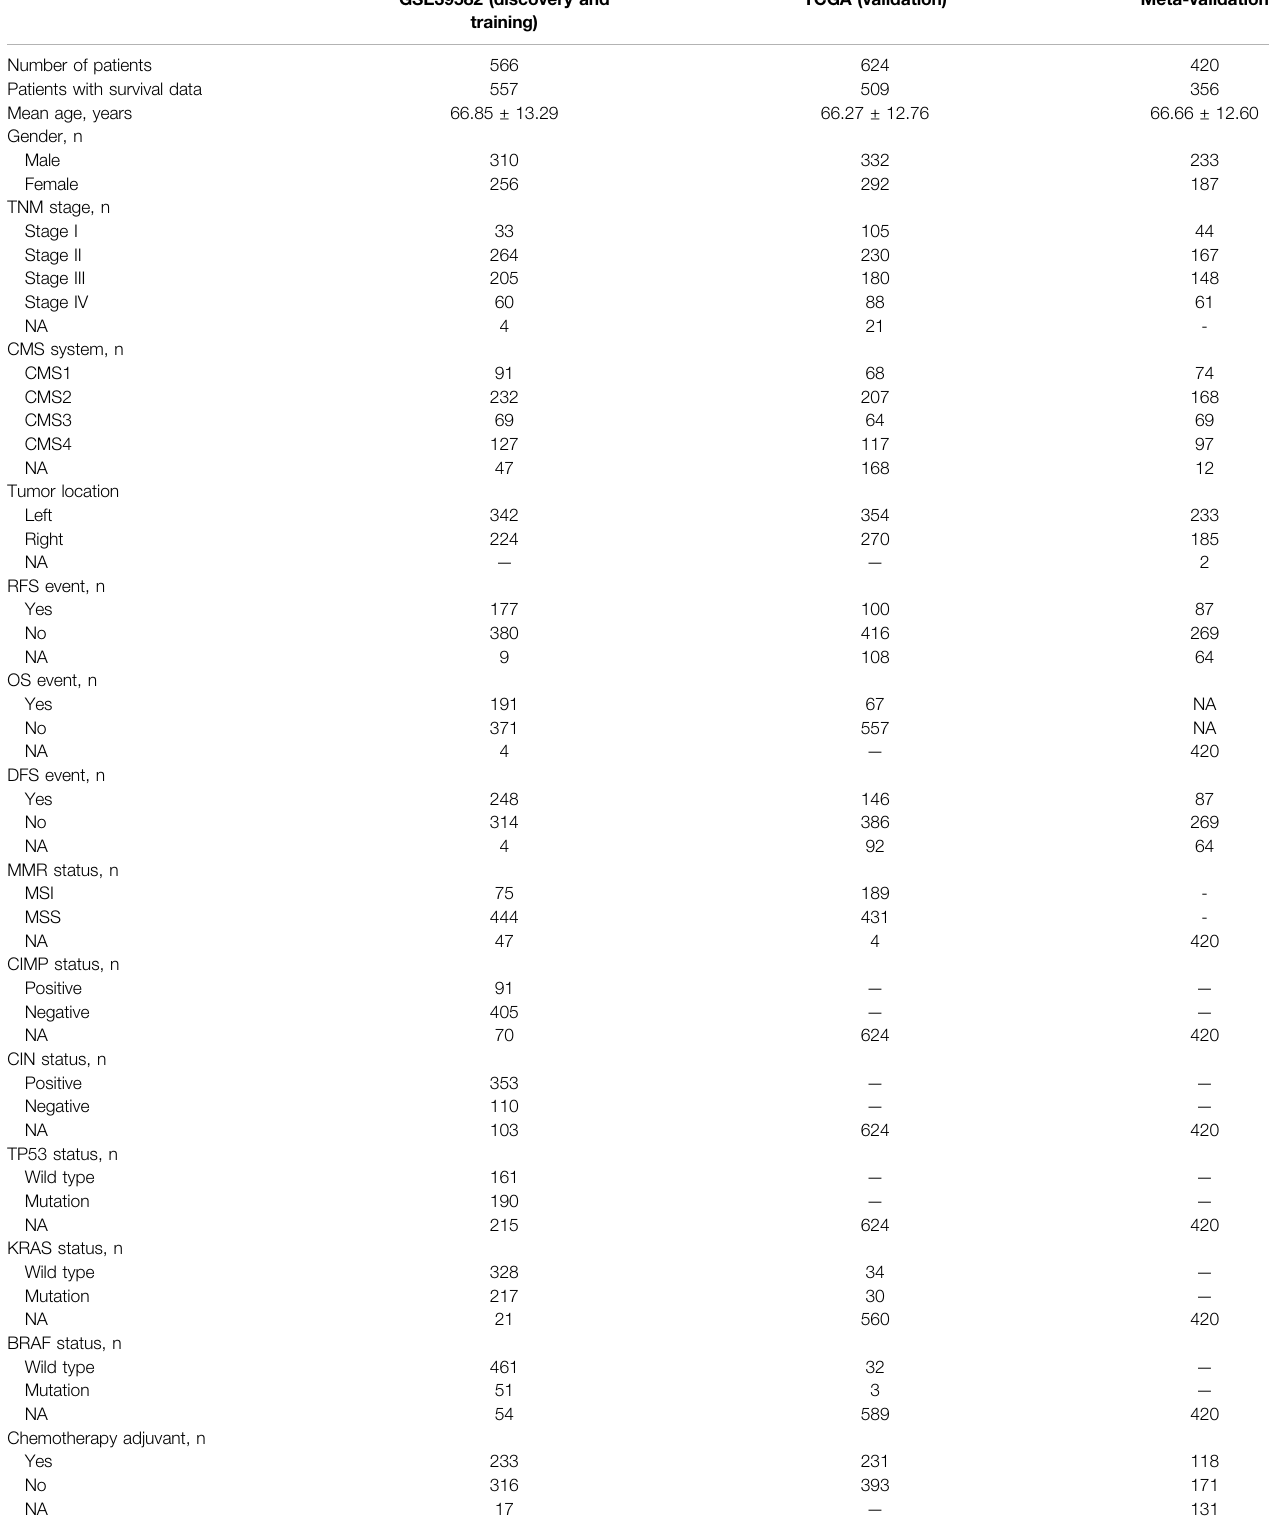
TABLE 1 | Characteristics of GSE39582, TCGA, and meta-validation